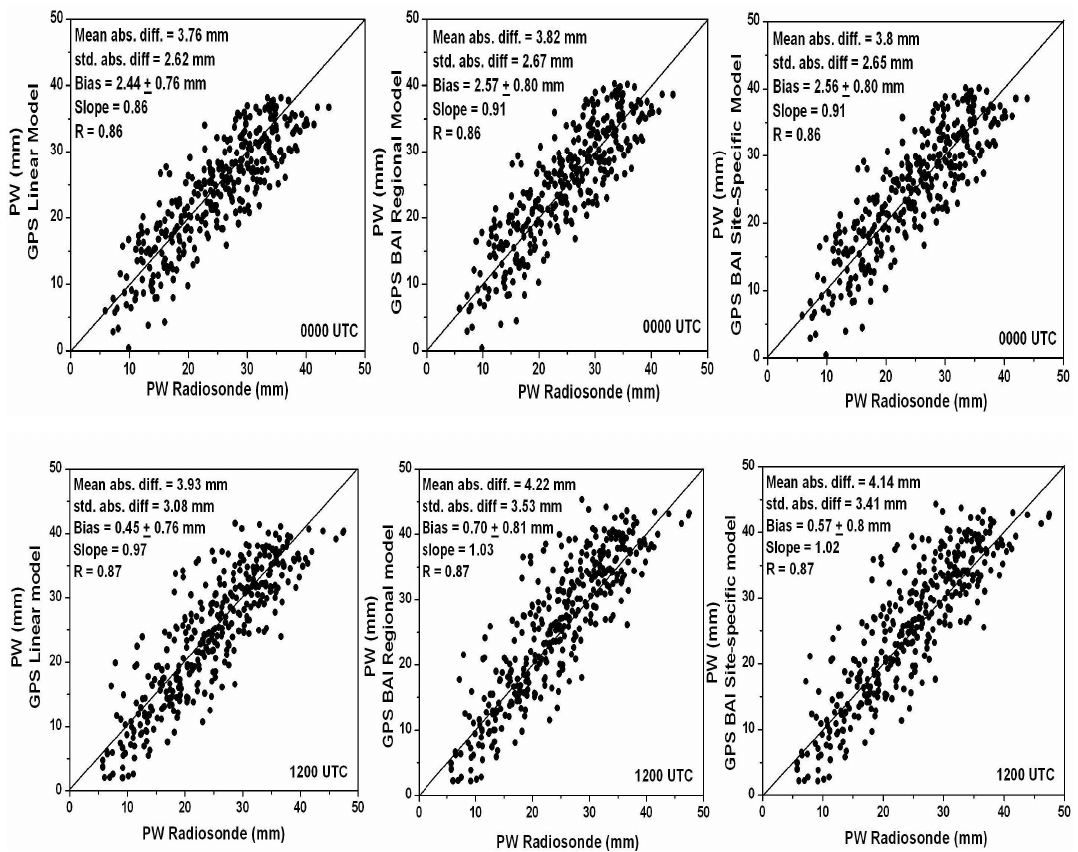
Fig. 9. A scatter plot of PW GPS estimated using linear model and BAI models verses the PW derived from the altitude profiles of water vapor estimated from radiosonde data for Bangalore. Scatter plot generated from the time-series data of PW GPS and PW derived from radiosonde for the period January 2001 to October